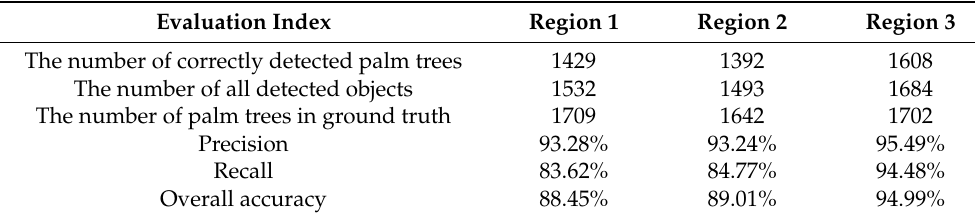
Table 3. Detection results of template matching